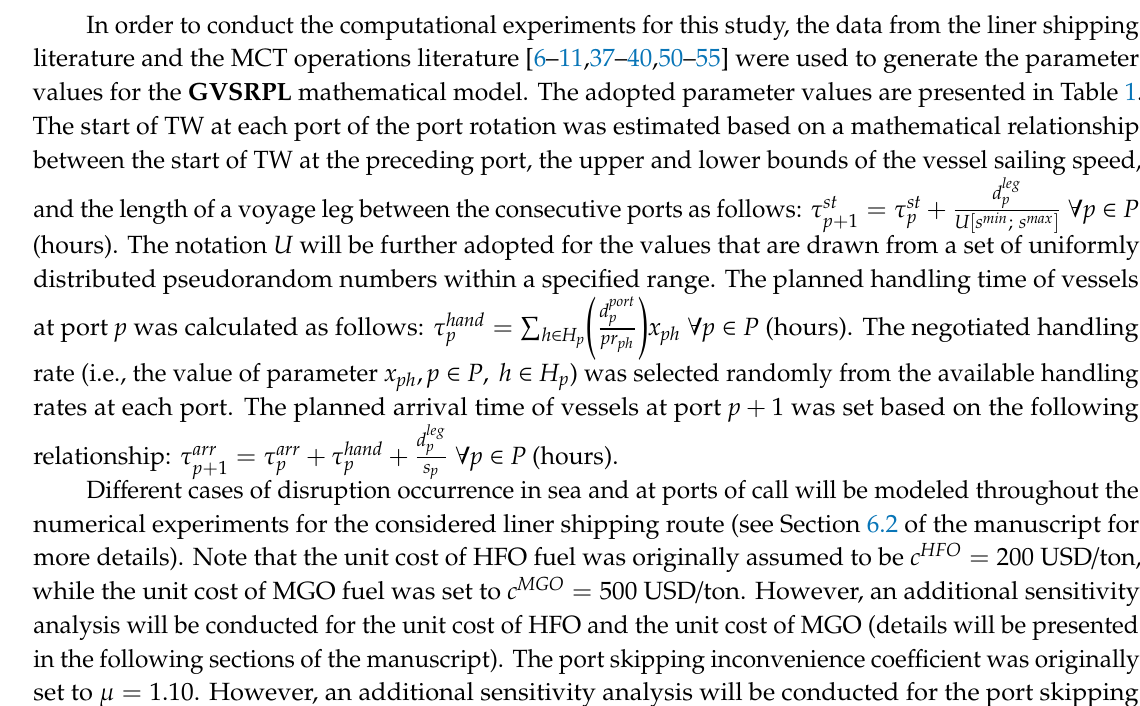
Table 1. The parameter values used for the numerical experiments.